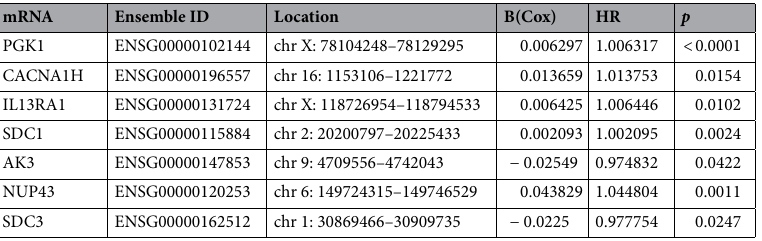
Table 2. The detailed information of seven prognostic mRNAs significantly associated with overall survival in patients with breast